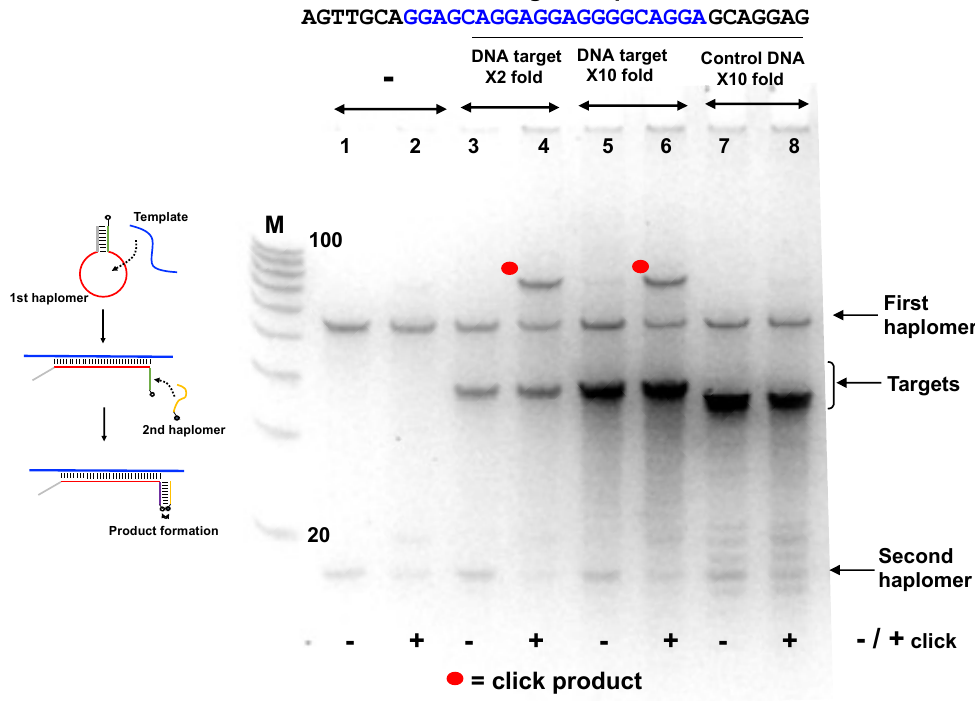
Figure 5. Locked-NATS strategy in conditions of template excess, using the EBNA1 First haplomer bottle (Lk-EBV1; 5 ′ -hexanyl-TTCGACTCGAGACGTCTCCTTCCTGCCCCTCCTCCTGCTCCGAGACGTCTCGAGT) and second haplomer (Lk2; GACGTCTCGAGTTCTT-3 ′ -azide) with a DNA oligonucleotide corresponding to the EBNA1 repeat se- quence (“Target template”; sequence as shown with the central region complementary to the First haplomer loop in blue text). The EBNA1 first haplomer bottle was initially pre-self-annealed in the same manner as for the First haplomer bottle in Figure 4. Samples of the self-annealed first haplomer bottle were then incubated in 10 mM Tris-HCl pH 7.5/10 mM MgCl 2 /50 mM NaCl/1 mM dithioerythritol at a final concentration of 2 µM, along with the DNA template at both 2-fold and 10-fold excess concentrations. In addition, a control non-specific DNA 35-mer oligonucleotide (GACTAGAC- GGCCAGGGAGACGAATACATATTCAAT) was used, also at a 10-fold excess concentration. After a 2 h/37 °C incuba- tion, the second haplomer was added to a final concentration of 2 µM, and the incubation continued for a final 1 h/37 °C. Following this, 10 µL samples from each test were subjected to +/ − click reactions in the same manner as for Figure 4. Samples (1 µL) were analyzed on 10% 8 M urea denaturing 10% (19:1) acrylamide gels after denaturation in 98% forma- mide at 98 °C/3 min and immediate transfer to ice. M = 100/20 molecular weight markers (IDT; 10-base decrements from 100 bases). Further oligonucleotide details for Lk-EBV1 and Lk2 haplomers are provided in Supplementary Tables S2 and S3.